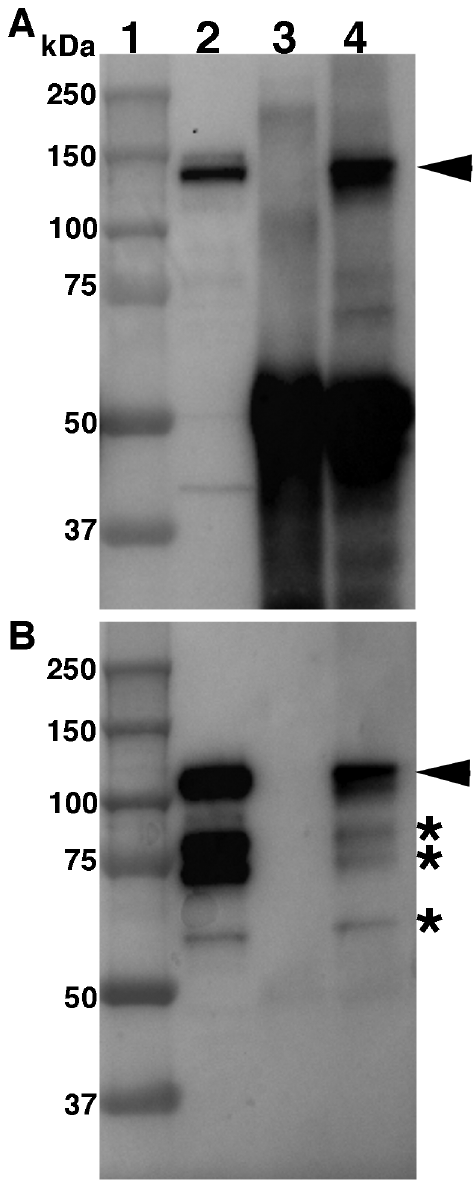
Figure 1. Cadherin-7 and N-cadherin physically interact in vivo. Lysate from HH15-16 trigeminal ganglion tissue was incubated with either an antibody against N-cadherin or with whole rabbit IgG serum as a control. Immuno- precipitated proteins were captured with protein A/G beads, separated by SDS-PAGE, followed by immunoblotting for N-cadherin (A) and Cadherin-7 (B). Lanes 1-4 are as follows: 1) Protein ladder; 2) Input, trigeminal ganglia lysate; 3)trigeminalganglia lysate followingIPwith rabbitIgG;and 4) trigeminalganglia lysatefollowing IPwithN-cadherin antibody. Arrowheads point to N-cadherin (A) or Cadherin-7 (B), respectively, while asterisks identify